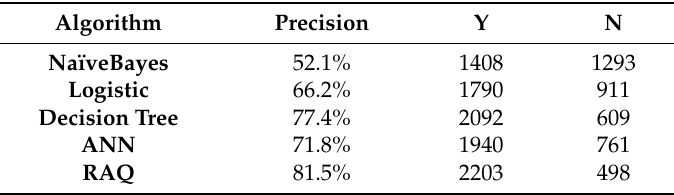
Table 6. Precision table of different algorithms.